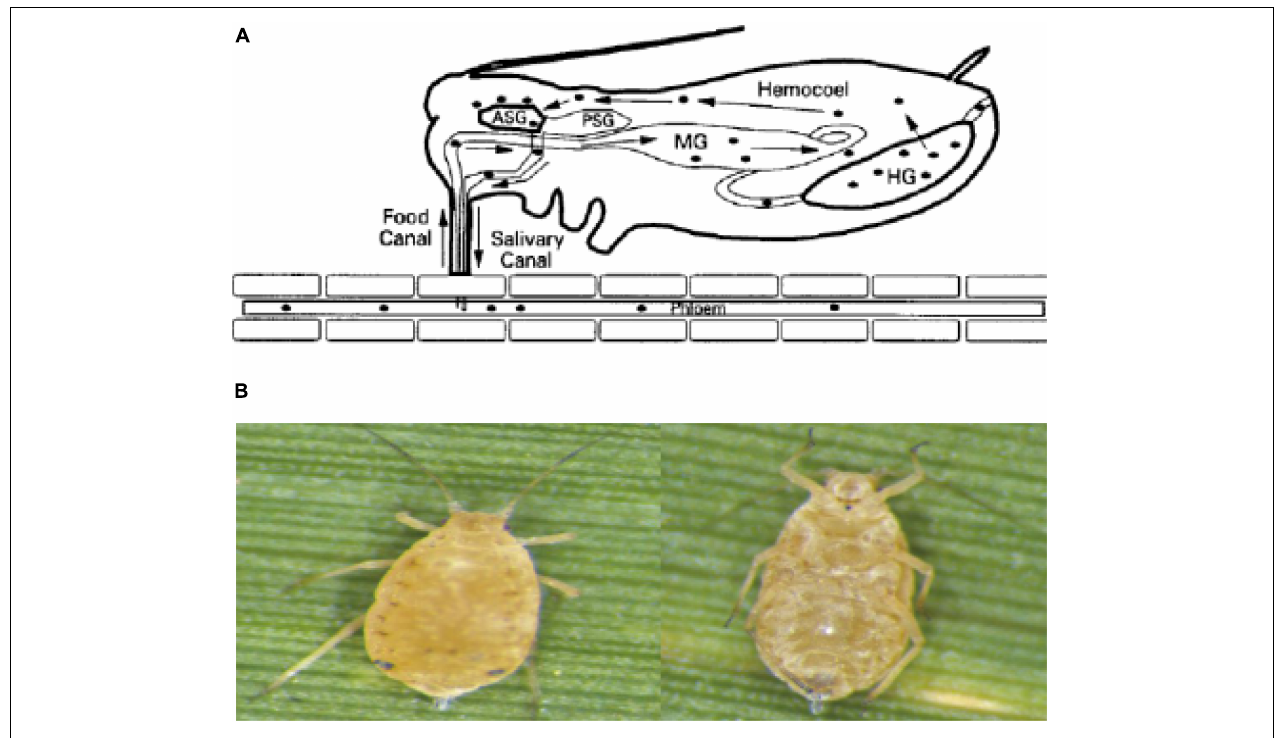
FIGURE 1 | (A) The path of the virus in aphids. (B) The aphid’s vector of ScYLV. Left: back view of the aphid. Right: abdomen view of the aphid.